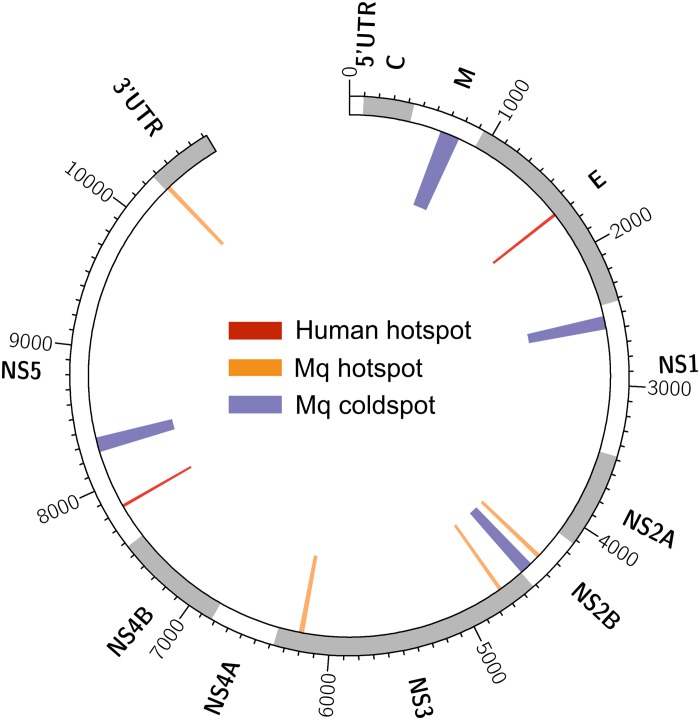
Mutational hot- and coldspots in the DENV2 genome.Circos plot [26] of mutational hot- and coldspots detected in human- and mosquito-derived DENV2 populations. Red, hotspots in human-derived populations; orange, hotspots in mosquito-derived populations; each hotspot was found in a single population. Purple, coldspots indicating a depletion of SNVs across all 46 mosquito-derived populations. No coldspots were detected in human-derived populations.